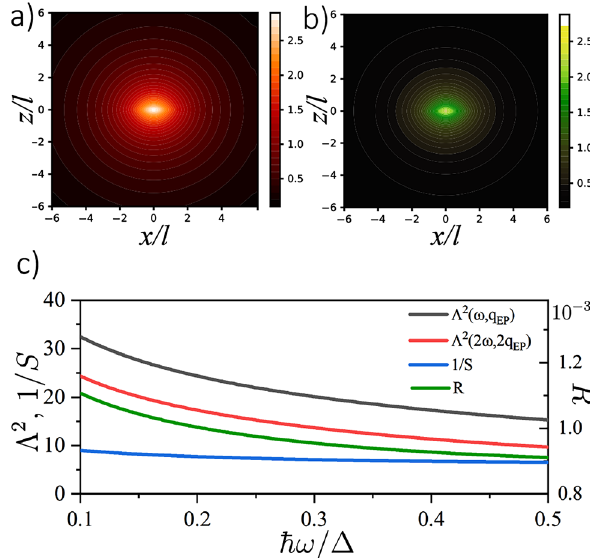
Figure 3: Profiles of the E y component of the EPP fi eld at ℏ ω / Δ (cid:1) 1 / 3 (a) and ℏ ω / Δ (cid:1) 2 / 3 (b). (c) Spectrum of different contributions to the SHG enhancement factor R . EPP, edge plasmon-polariton; SHG, second-harmonic